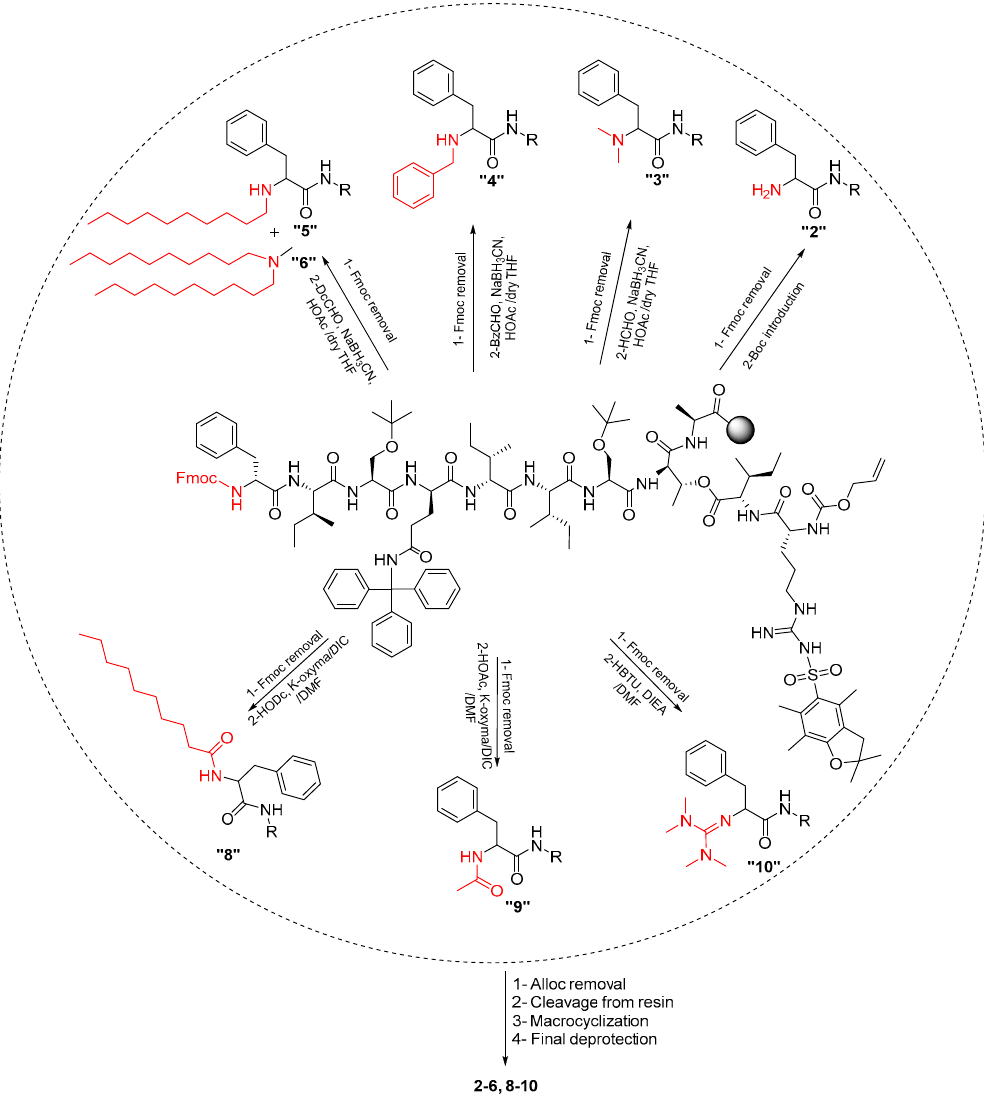
Figure 2. Chemical structure of the teixobactin analogs 2 – 6 , 8 – 10 used in this study; “ 2 – 6 , 8 – 10 ” are the protected linear precursors of 2 – 6 , 8 – 10 .